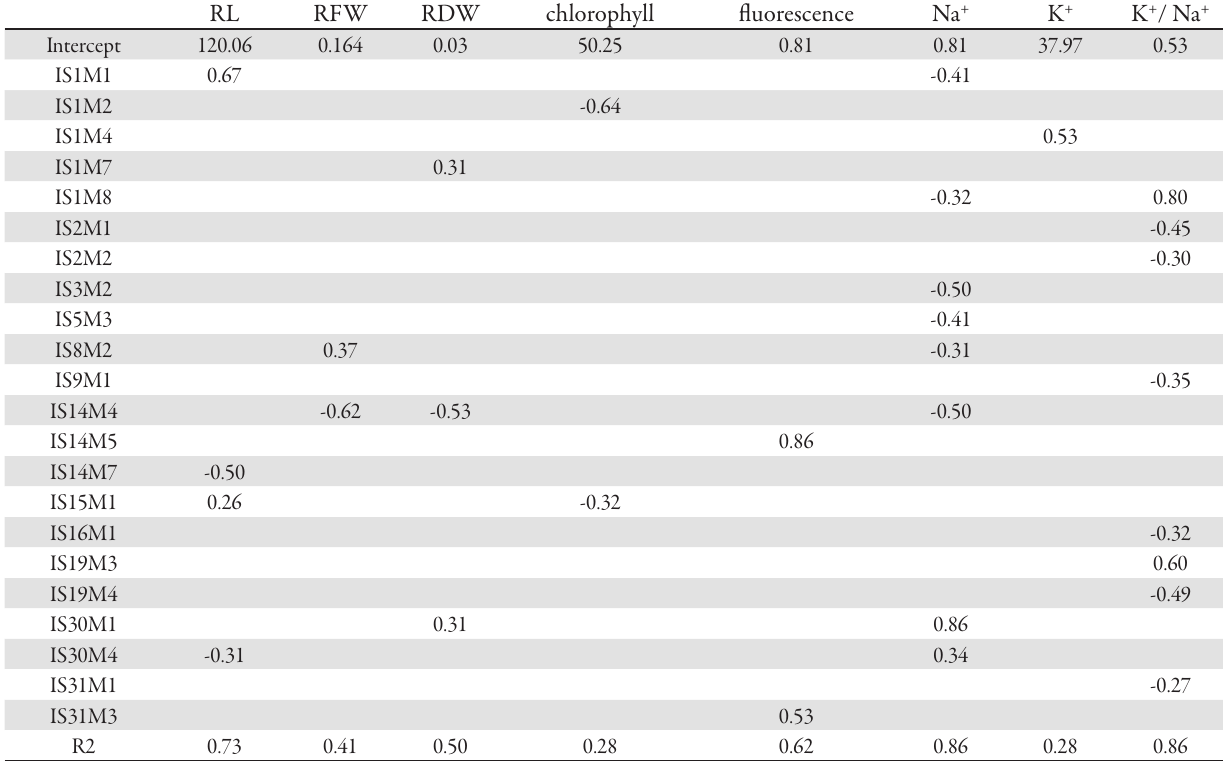
Tab. 3. Regression coefficients and adjusted R square in the multiple regression between the agronomic triats and location